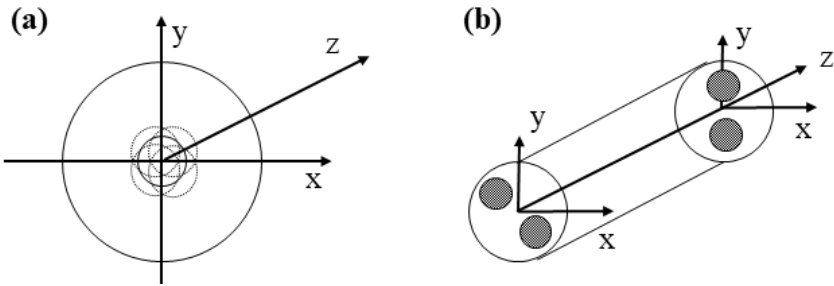
Figure 2. ( a ) Helical-core fiber with an eccentric core. ( b )Twisted linear birefringence fiber.